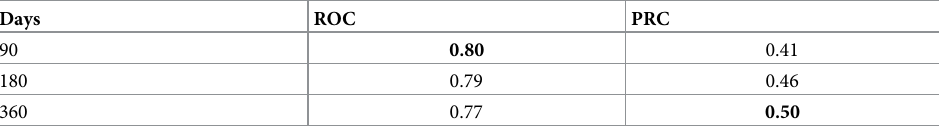
Table 2. Result of 10-fold cross-validation of the automatic risk prediction system (GBRT) to predict the endpoint “infection” on retrospective data, according to Area under Receiver Operator Curve (ROC) and Area under Preci- sion-Recall Curve